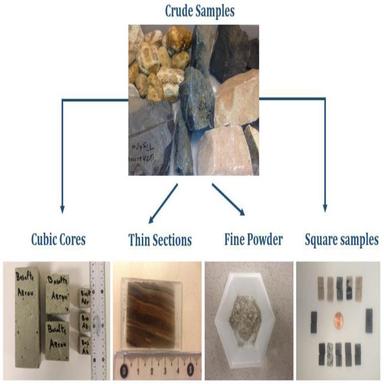
Preparation of the studied rocks for experimental characterization.